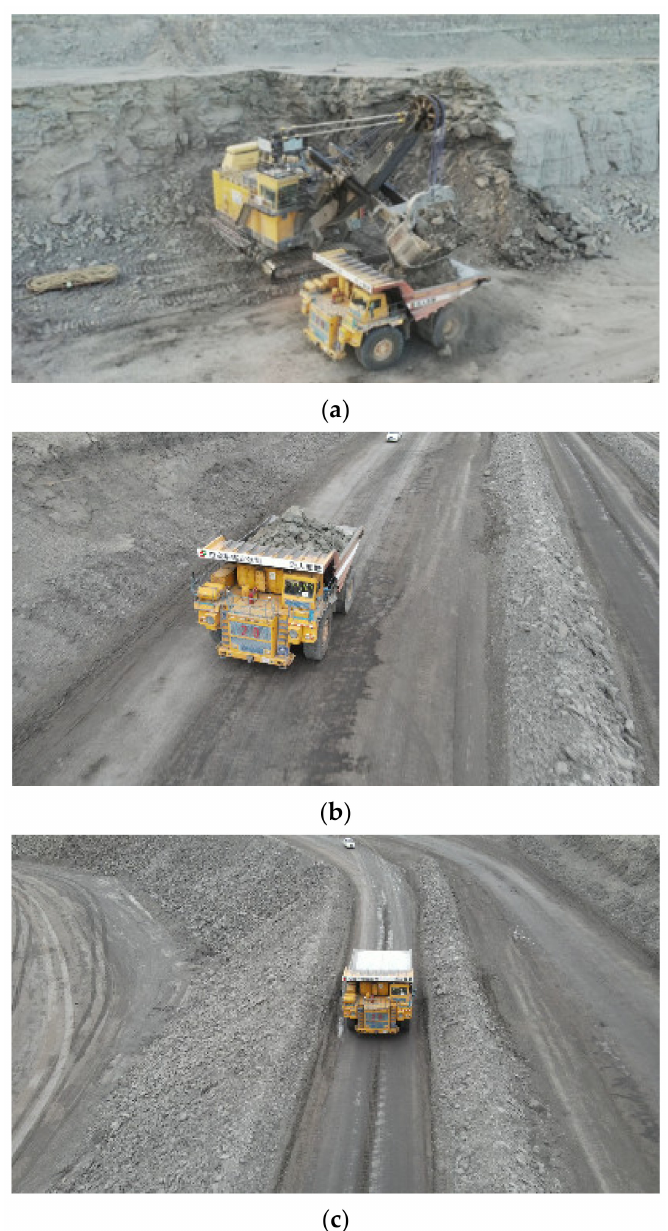
Figure 8. Working cycle test of the mining truck: ( a ) Loading process of the mining truck; ( b ) Uphill process with full load; ( c ) Downhill process without